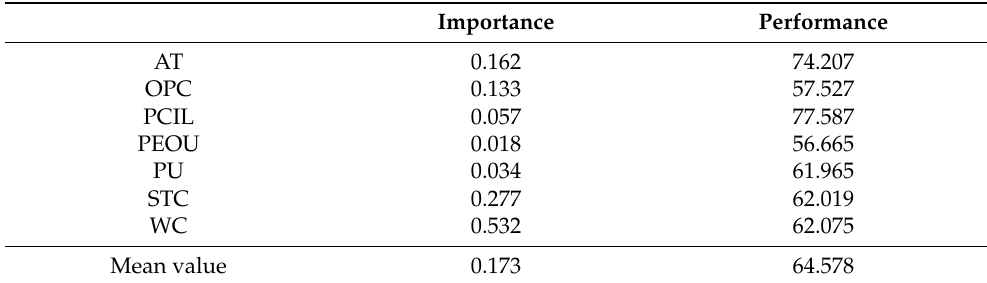
Table 12. Data of the importance–performance map for extended use of ERP system (ExU).